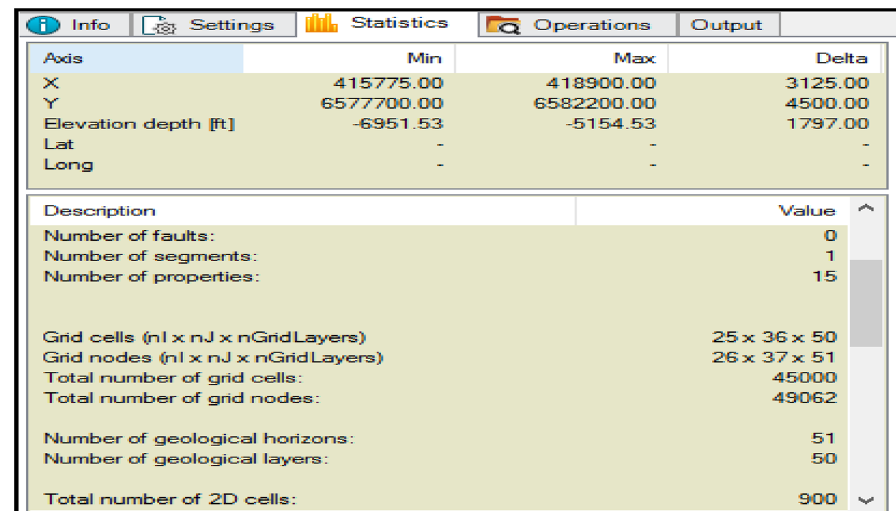
Fig. 3 3D grid statistics of the reservoir skeletal